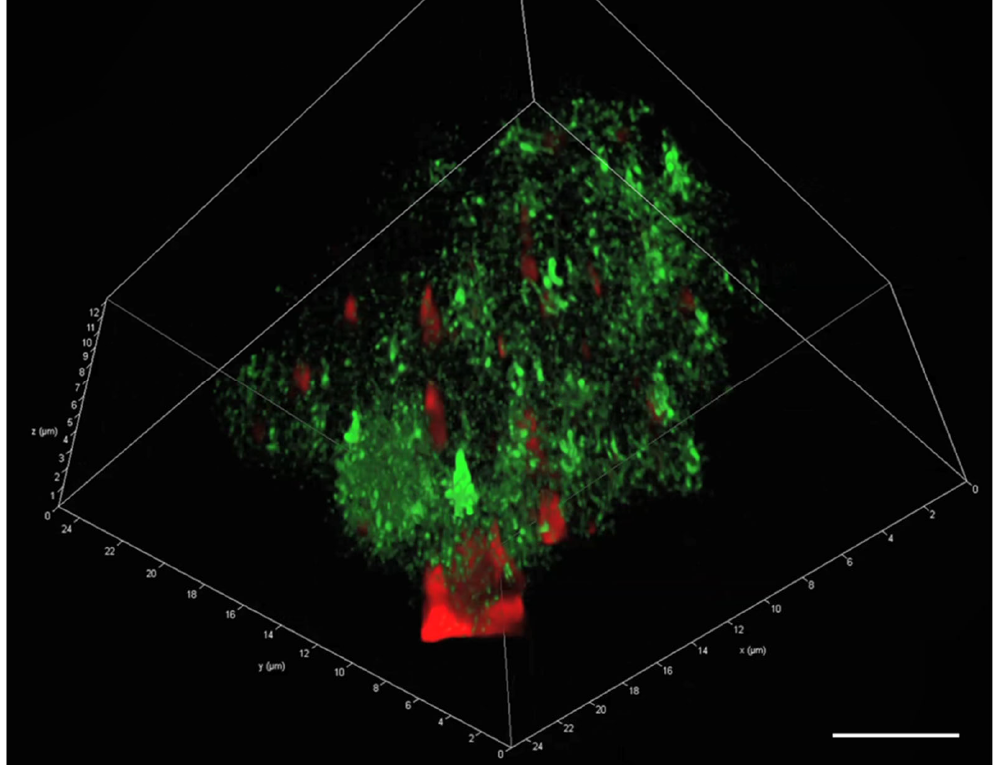
Figure 5. A 3D image of a single natural MGP stained with YOYO-1 (green = extracellular DNA) and Nile red (red = cell membrane). Scale bar = 5 µm. Image captured with Leica SP8 CLSM. The visualisation of the MGP matrix components using CLSM showed that TOTO-3 (eDNA, red) has the highest fl uorescence intensity of the triple staining set that also con- tains Con A (glycoproteins, blue) and SYTO 9 (iDNA, green) (Figure 6A,B).